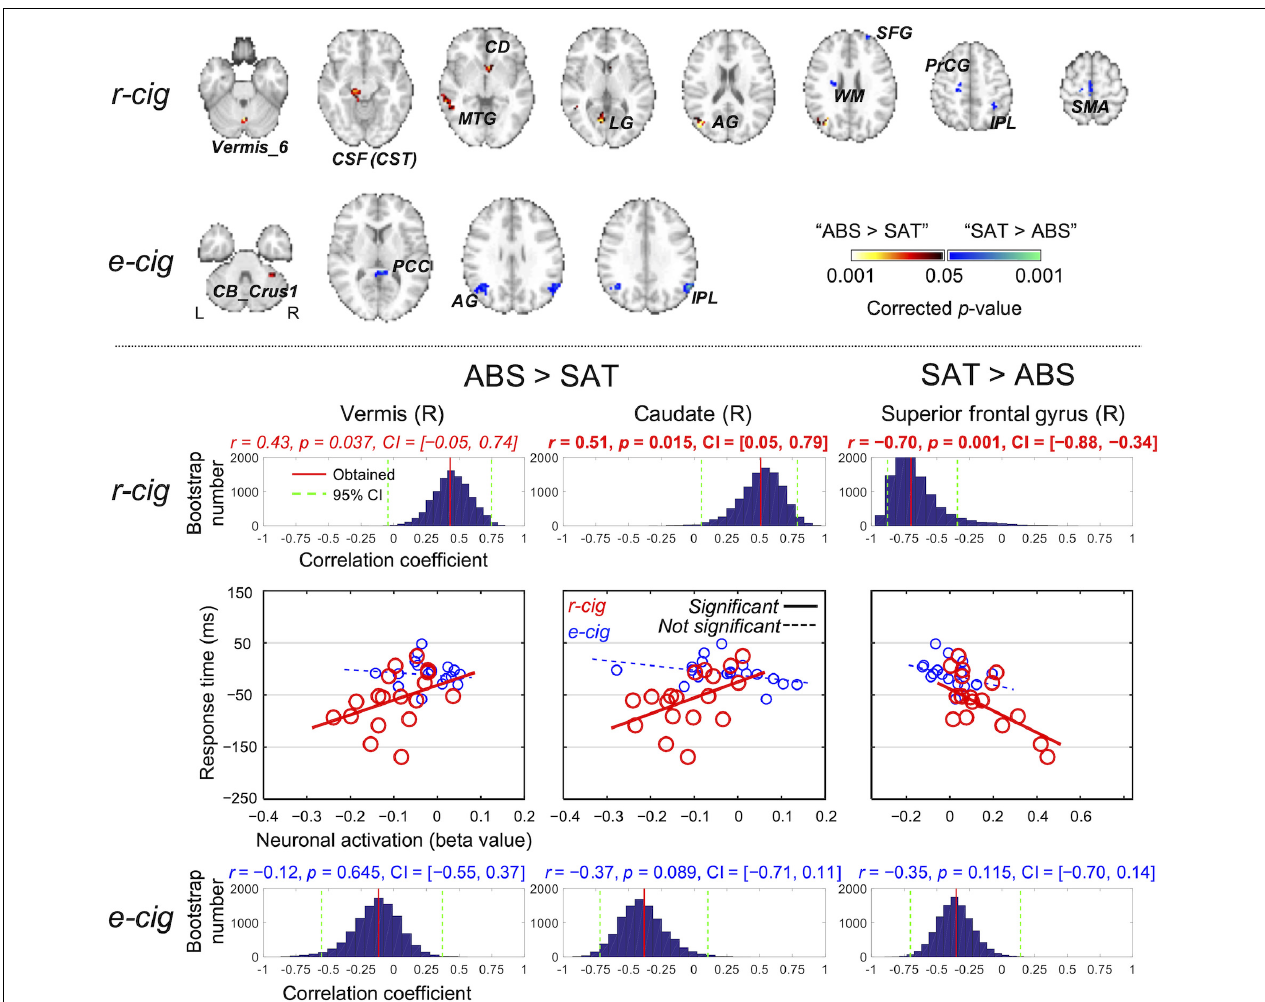
FIGURE 3 | Regions-of-interest (ROIs) identified from the contrast of the satiated and abstained states for each of the two cigarette smoking conditions (top). A significant association between the neuronal activations of the ROIs and the response time for the 3-back alphabet/digit recognition task was obtained using regression analysis only from the three ROIs identified from the r-cig smoking condition (bottom). The corresponding p -value was corrected using 10,000 random permutations, and the statistical significance was evaluated based on the 95% confidence interval (CI) obtained from 10,000 bootstrapping cycles. L, left; R, right; SAT, satiated state; ABS, abstained state; CB, cerebellum; PCC, posterior cingulate cortex; AG, angular gyrus; IPL, inferior parietal lobule; CSF, cerebral spinal fluid; CST, corticospinal tract; MTG, middle temporal gyrus; CD, caudate; LG, lingual gyrus; WM, white matter; SFG, superior frontal gyrus; PrCG, precentral gyrus; SMA, supplementary motor area; e-cigs, electronic cigarettes; r-cigs, regular tobacco